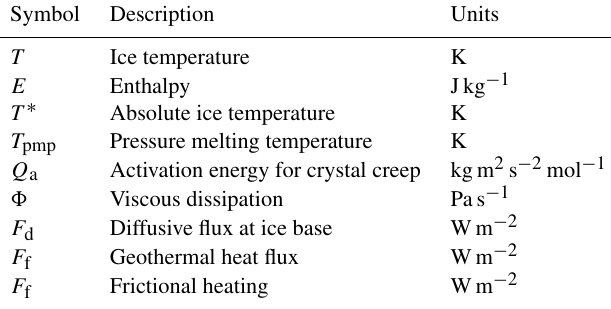
Table A4. Ice thermodynamics variables and